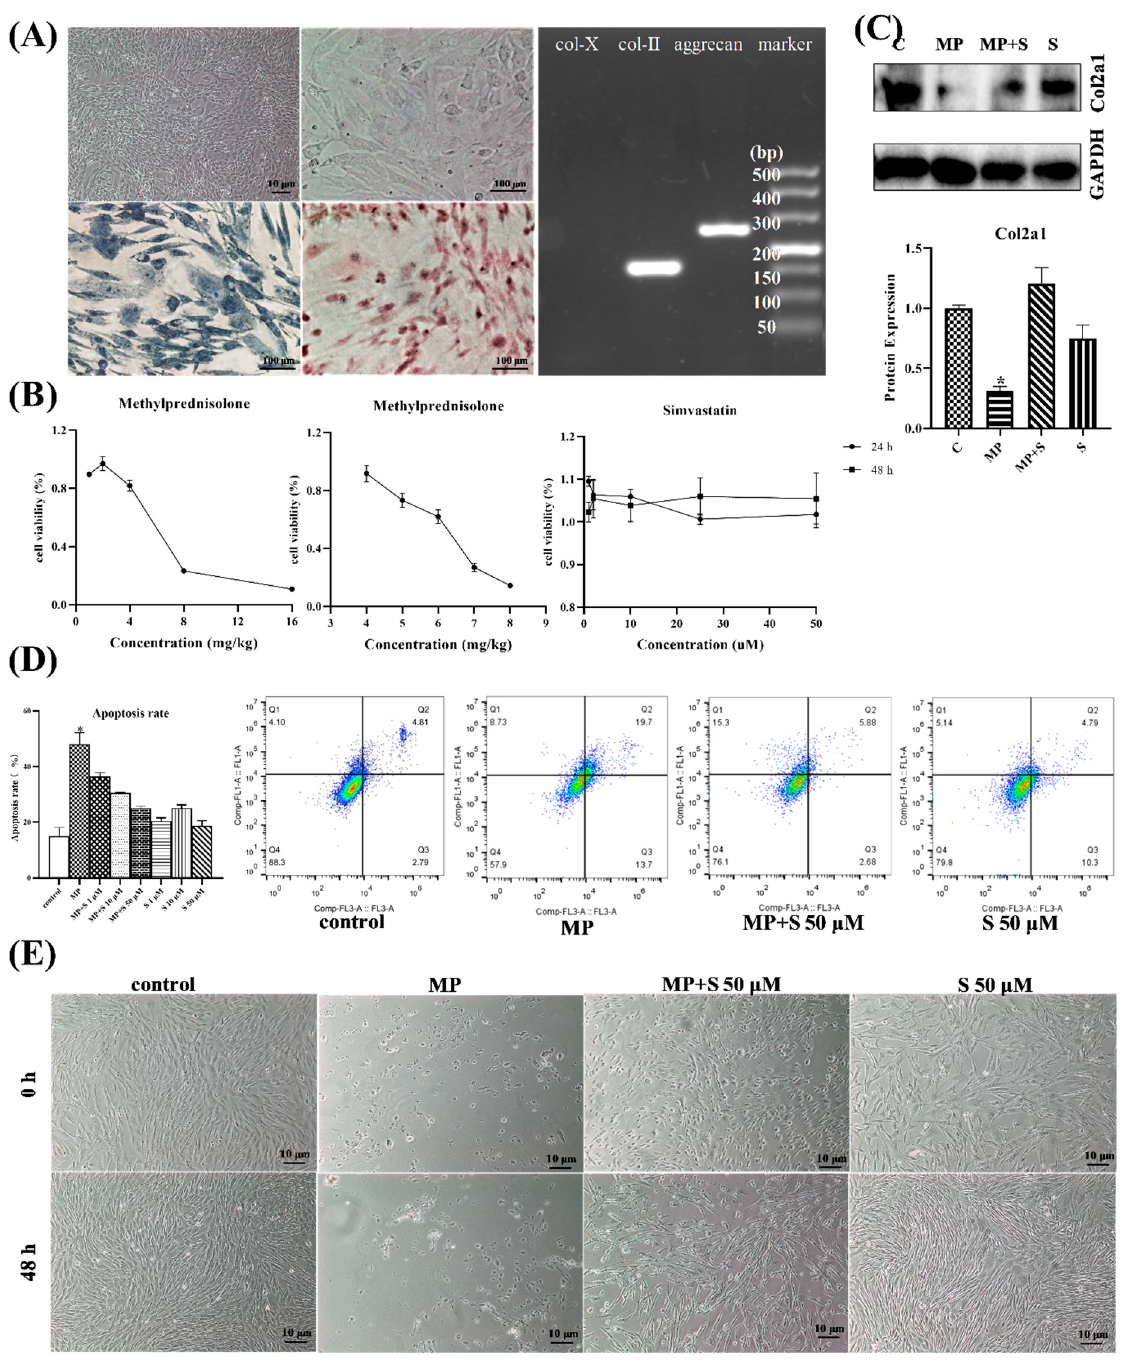
Figure 5. The MP-treated chondrocytes showed ECM degradation and apoptosis. ( A ) The chondro- cytes with toluidine blue staining of chondrocytes (200 × ) or alcian blue staining of chondrocytes (200 × ), and the results of touchdown PCR from chondrocytes. ( B ) The viability of chondrocytes under different concentrations of MP or simvastatin. ( C ) The col-2a1 expression of chondrocytes with different administrations. ( D ) The results of apoptosis of cells in different groups by flow cytometry determination. ( E ) The results of chondrocytes with different treatments. (40 × ). Here, * p < 0.05 vs. control group.